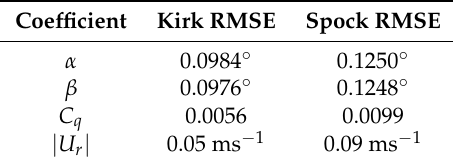
Table 1. Root-mean-square error (RMSE) of calibration